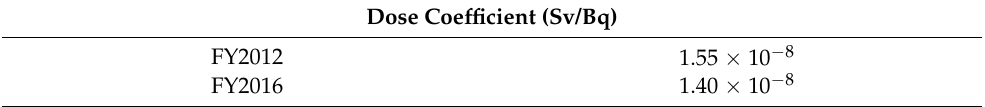
Table 2. Used dose coefficients for the sum of radioactivity concentration of Cs-134 and